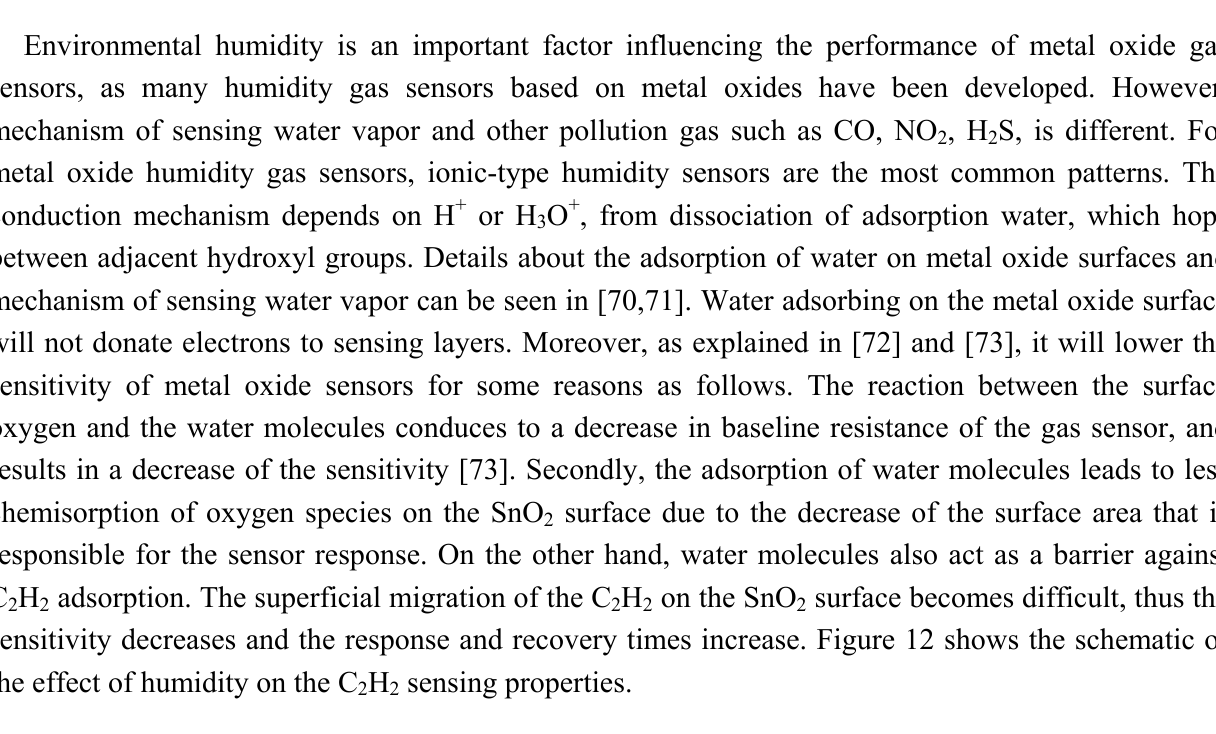
O -doped SnO 2 3